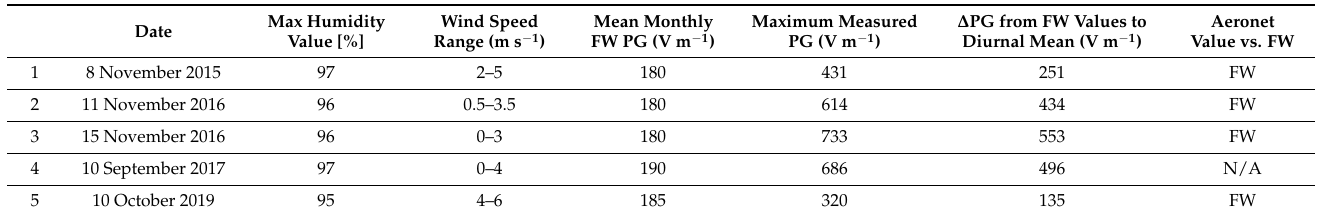
Table 1. Five case studies on the effect of radiation fog on measured PG during 6:00–9:00. FW stands for fair weather.